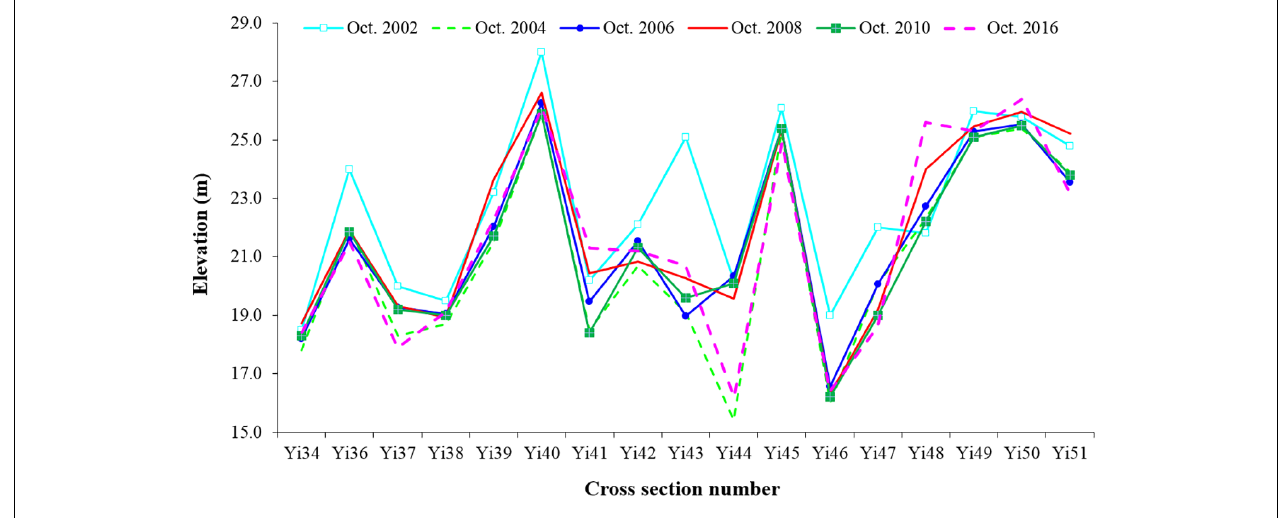
FIGURE 4 | Thalweg variations along the Yichang reach before and after the impoundment of the Three Gorges Reservoir.